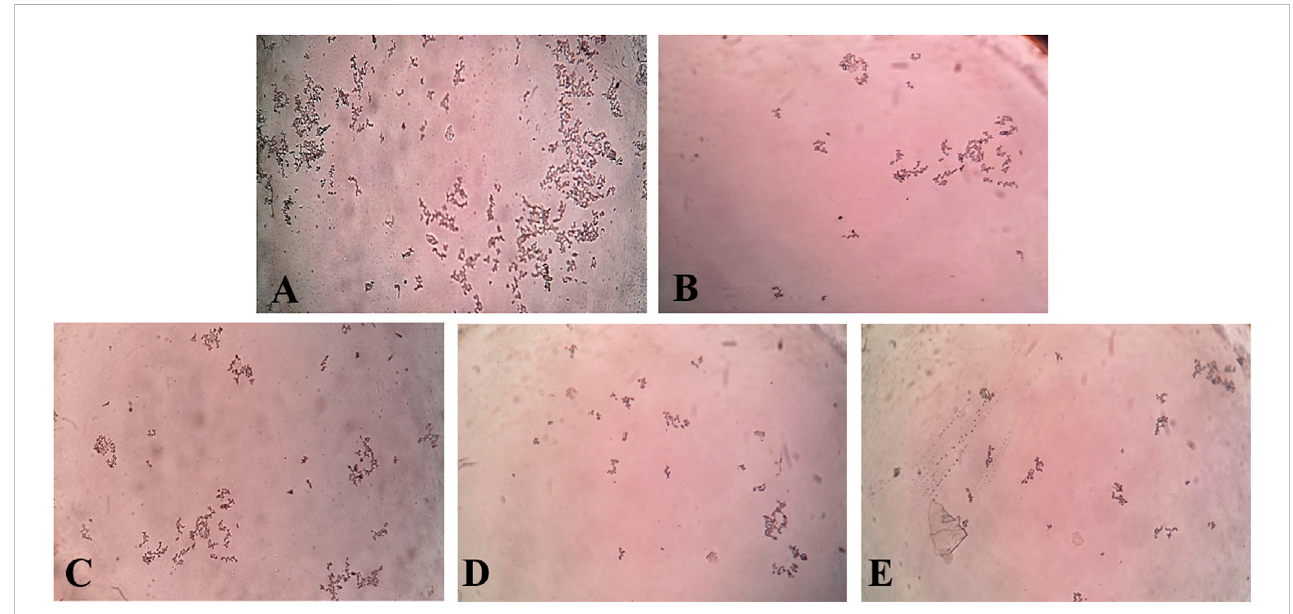
FIGURE 2 Photomicrograph of CaOx crystal density in different solutions. [ (A) = Control, (B) = Cystone, (C) = AEEF (50 μ g/mL), (D) = AEEF (100 μ g/mL), (E) = AEEF (200 μ